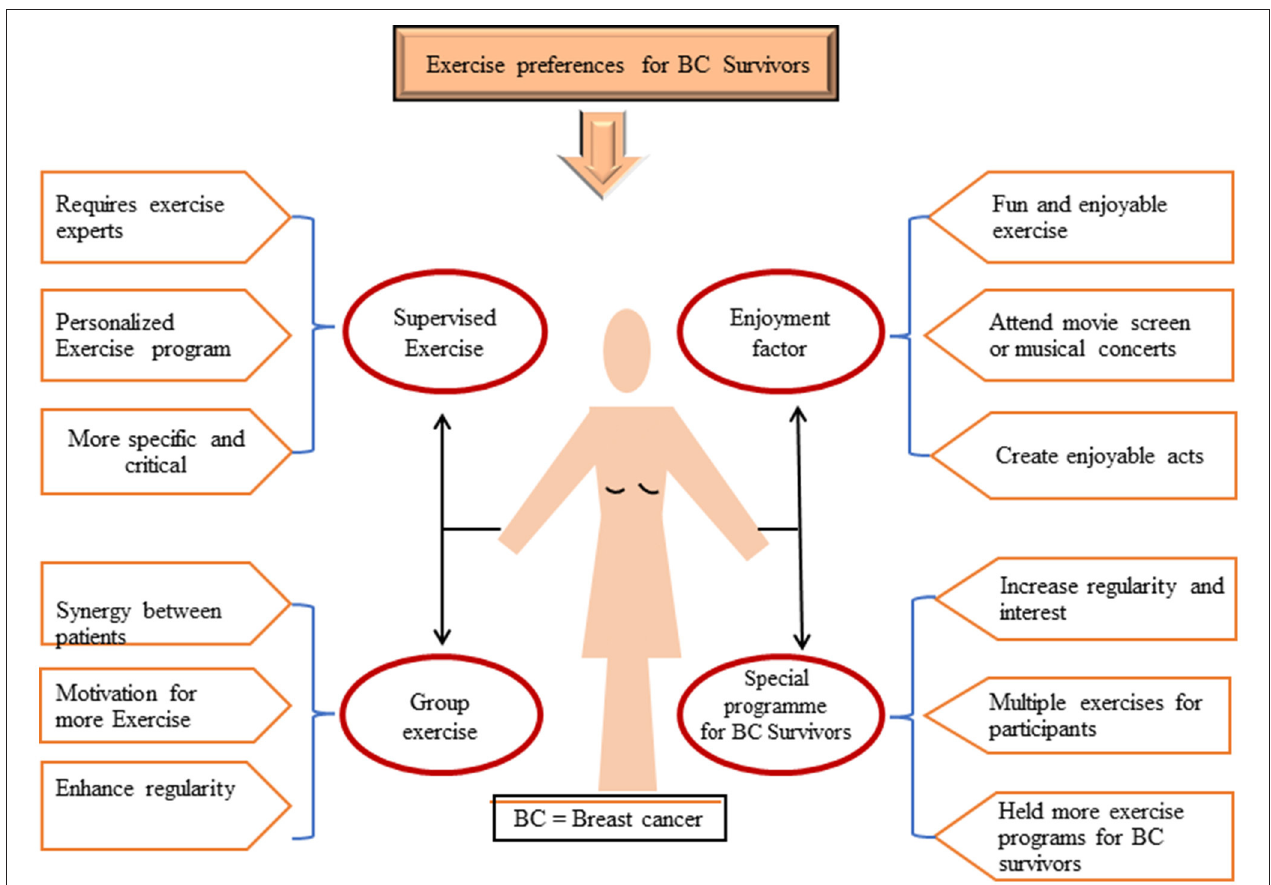
FIGURE 4 | Available preferences of exercises for BC survivors in the form of (i) supervised exercise, (ii) group exercise, (iii) special program for BC survivors, (iv) enjoyment factors. BC, breast